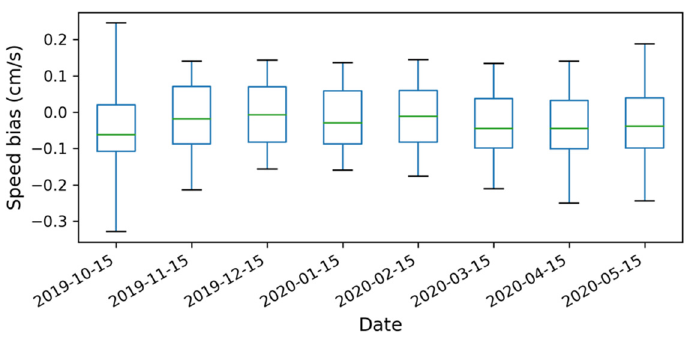
Figure 9. Bar plot of bias in estimated drift speed and the image acquisition date, sampled in every 360 30-day bins. 361